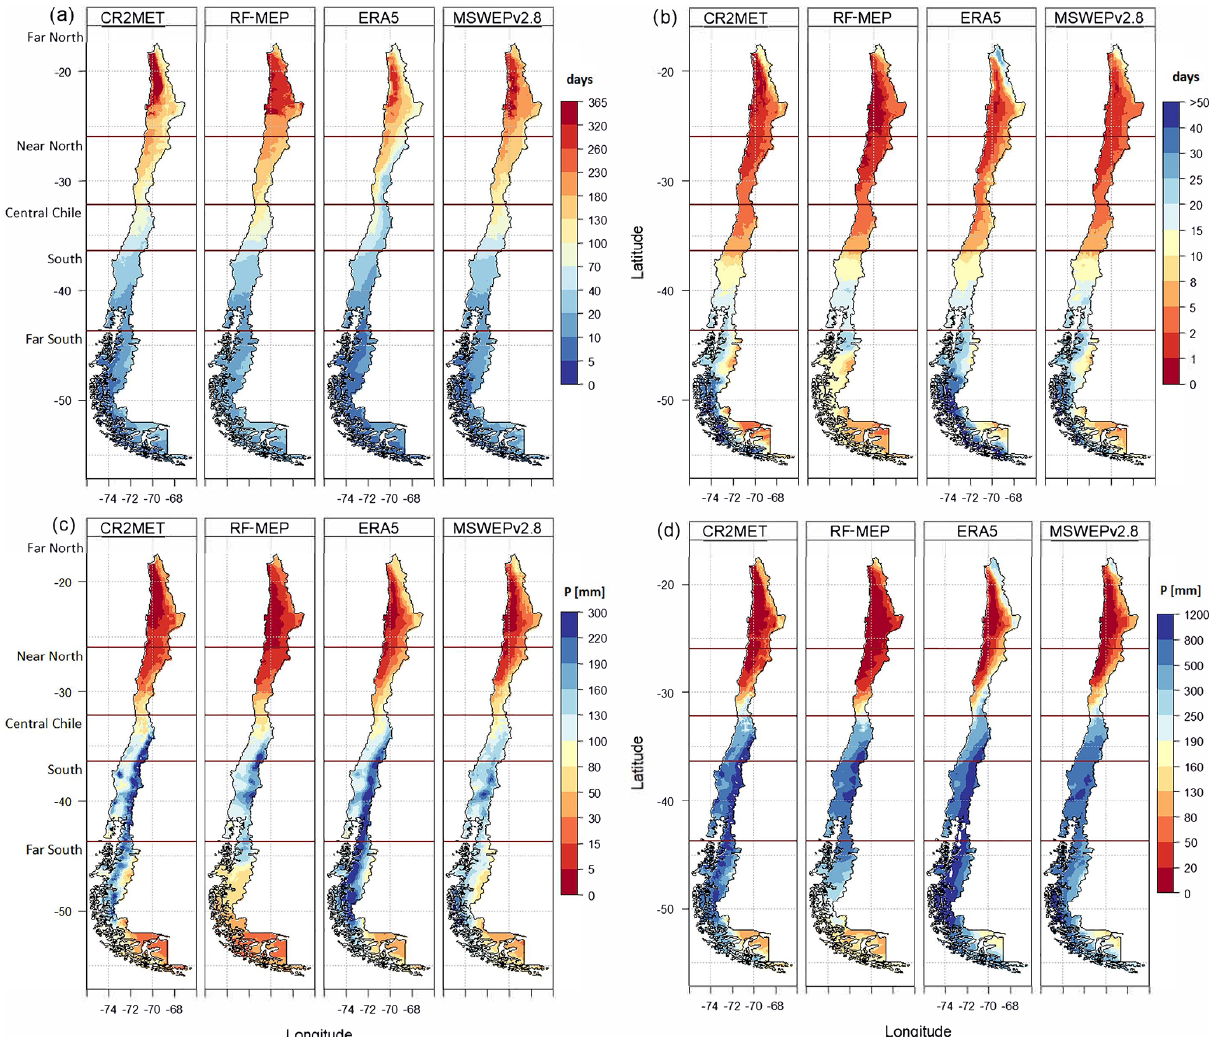
Figure 3. Median annual values of four Climdex indices over 1990–2018 (full period): (a) number of consecutive dry days (CDD), (b) number of consecutive wet days (CWD), (c) maximum P over five consecutive days (Rx5day), and (d) annual P that is above the 95th percentile of P for wet days (R95pTOT). The dark red horizontal lines represent the limits of each macroclimatic